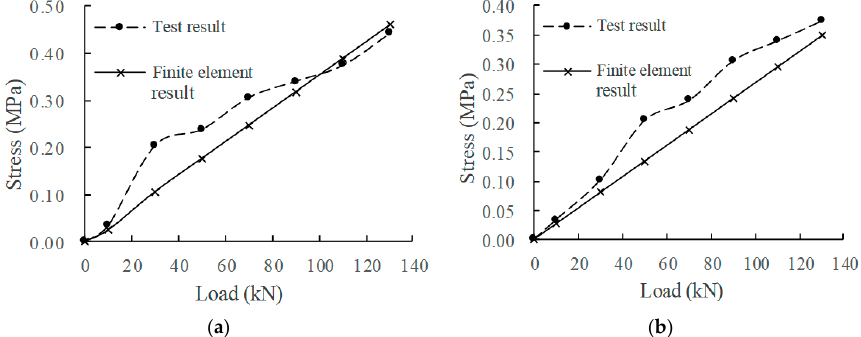
Figure 11. Stress of SCC: ( a ) 0 million times of train load; ( b ) 30 million times of train load.